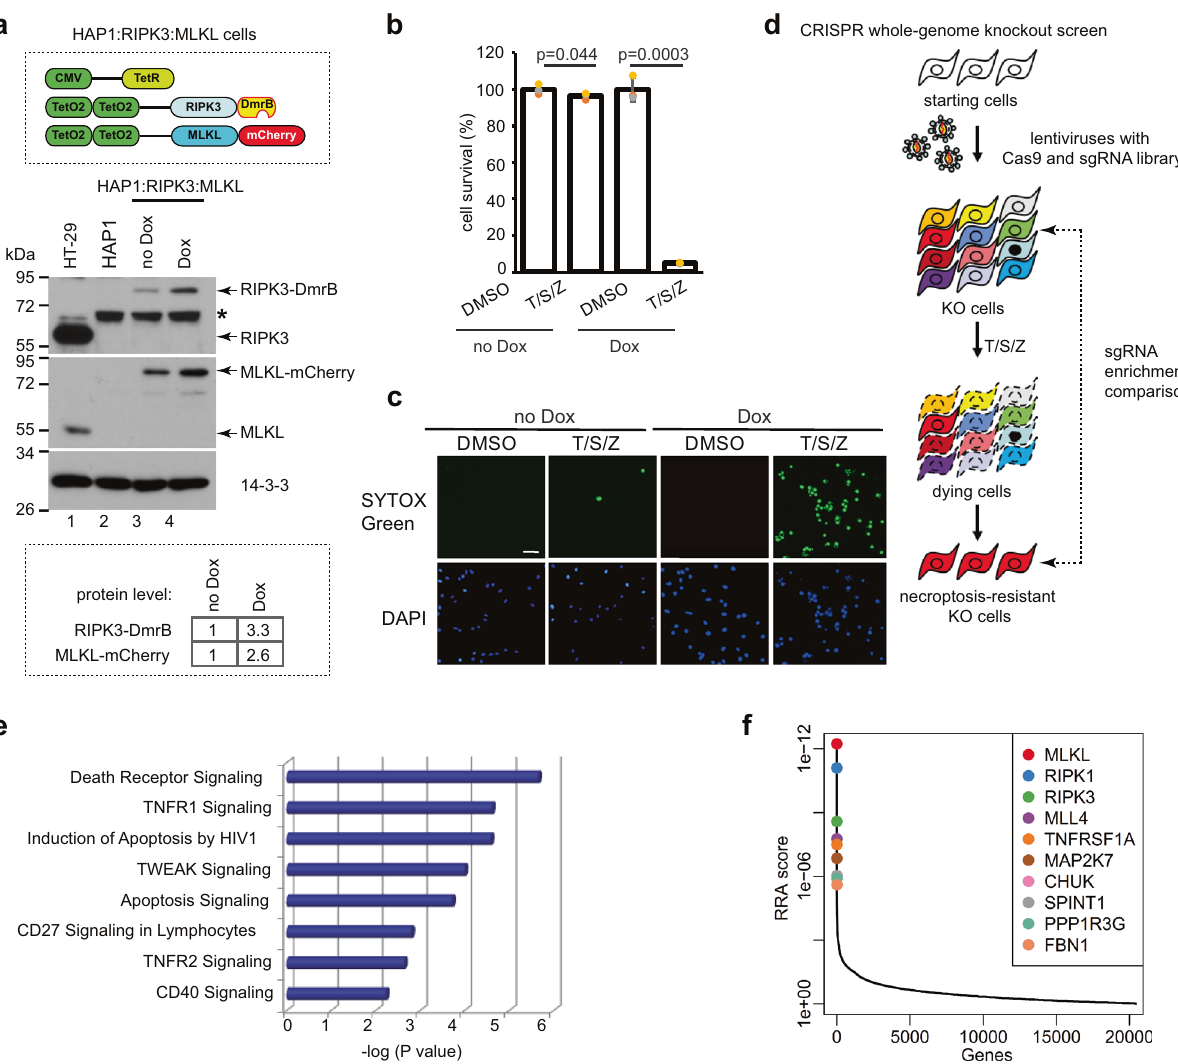
Fig. 1 CRISPR whole-genome knockout screen in modi fi ed HAP1 cells identi fi es genes essential for necroptosis. a Establishment of